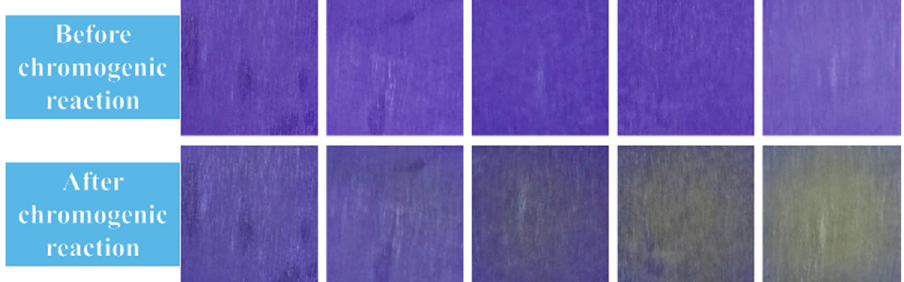
Figure 8: The photographs of NIM before and after adsorption of HA.